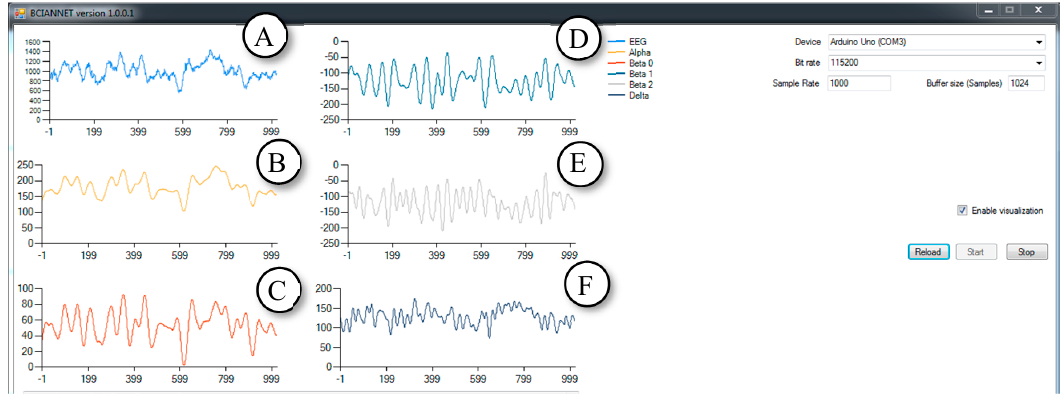
Figure 5. Improved version of the software which works similarly to the previous one but is an updated version that takes data from Arduino. Light blue ( A )—raw EEG. Yellow ( B )—alpha waves. Red( C )—beta 0 waves. Cyan ( D )—beta 1 waves. Grey ( E )—beta 2 waves. Dark Blue ( F )—delta waves.